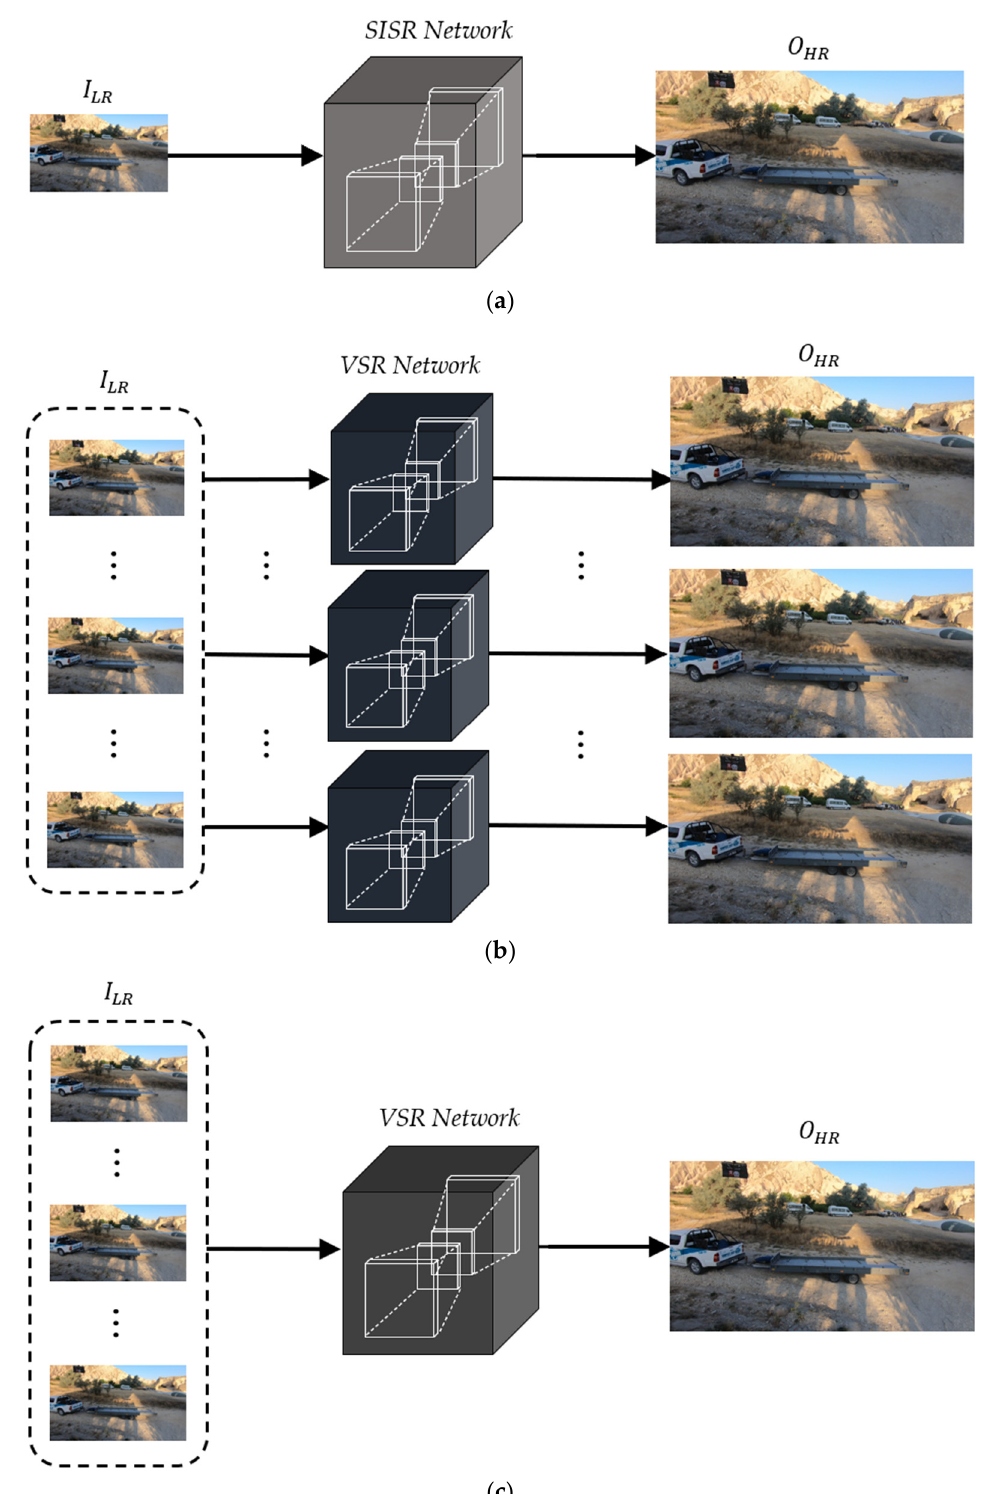
Figure 1. CNN-based image and video super-resolution schemes. ( a ) Single-image SR (SISR), ( b ) video SR (VSR) to generate multiple high-resolution frames, and ( c ) VSR to generate a single high-resolution frame.